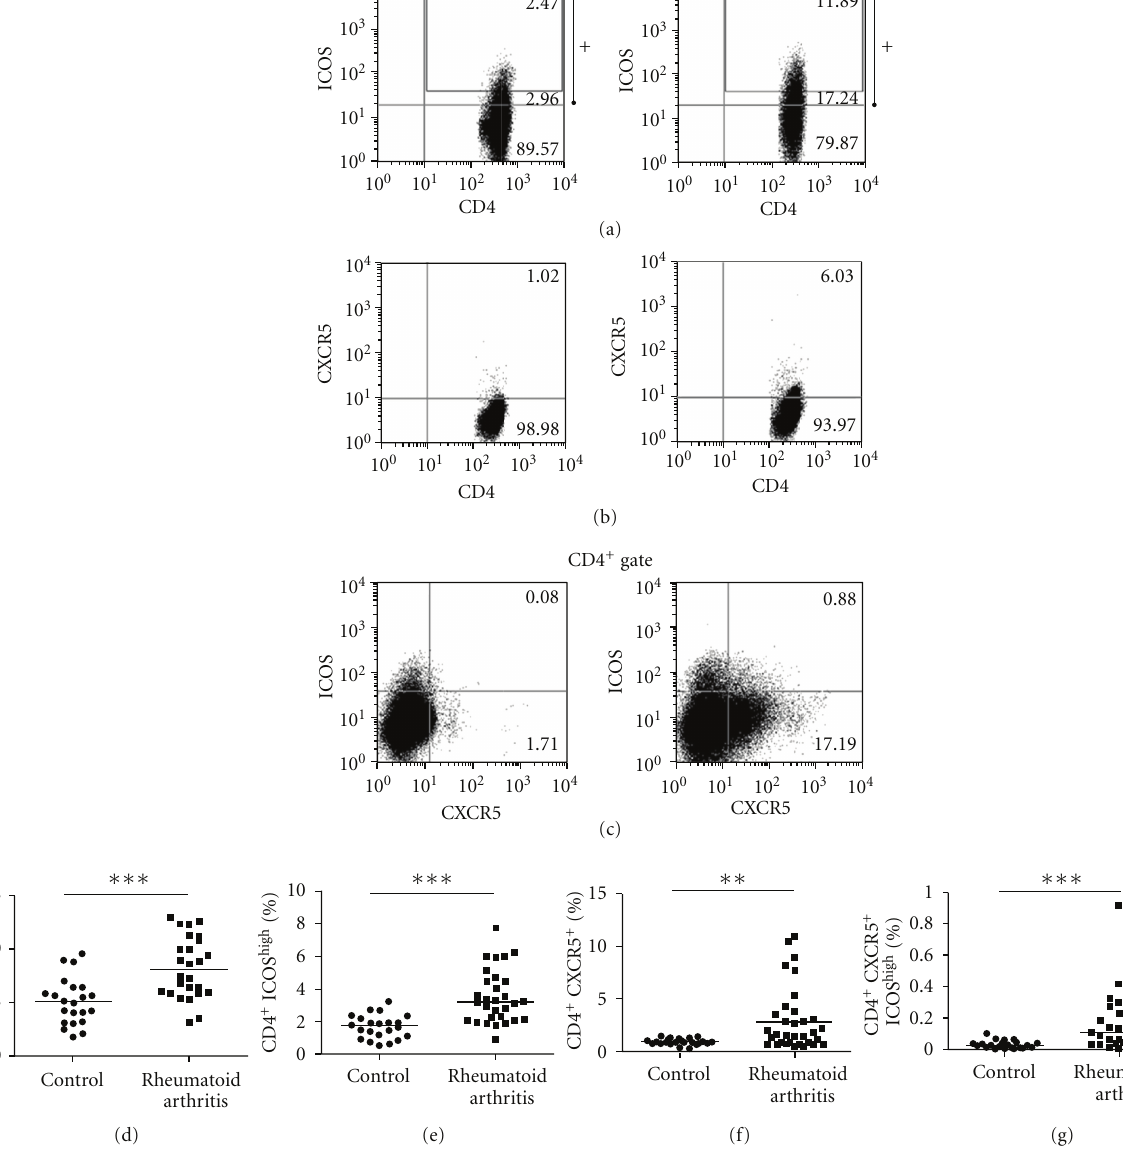
Figure 1: Increased frequency of circulating follicular helper T (Tfh) cells in peripheral blood from rheumatoid arthritis (RA) patients. Peripheral blood mononuclear cells (PMBCs) from RA patients ( n = 31) and healthy controls ( n = 30) were stained with labelled antibodies as described in Methods. (a) Representative expression of ICOS versus CD4 expression by flow cytometry, values in each CD4 + gate (ICOS high [black box], ICOS positive [ICOS intermediate plus ICOS high [+]], and ICOS negative). (b) Representative flow cytometry plots of Tfh (CD4 + CXCR5 + ) cells. (c) Representative flow cytometry plots of Tfh (CD4 + CXCR5 + ICOS high ) cells. (d) Percentage of CD4 + ICOS + T lymphocytes in RA patients and healthy controls ( ∗∗∗ P < 0 . 001). (e) Percentage of CD4 + ICOS high T lymphocytes in RA patients and healthy controls ( ∗∗∗ P < 0 . 001). (f) Percentage of CD4 + CXCR5 + T lymphocytes in RA patients and healthy controls ( ∗∗ P < 0 . 01). (g) Percentage of CD4 + CXCR5 + ICOS high T lymphocytes in RA patients and healthy controls ( ∗∗∗ P < 0 . 001). Each data point represents an individual subject, and horizontal lines show the